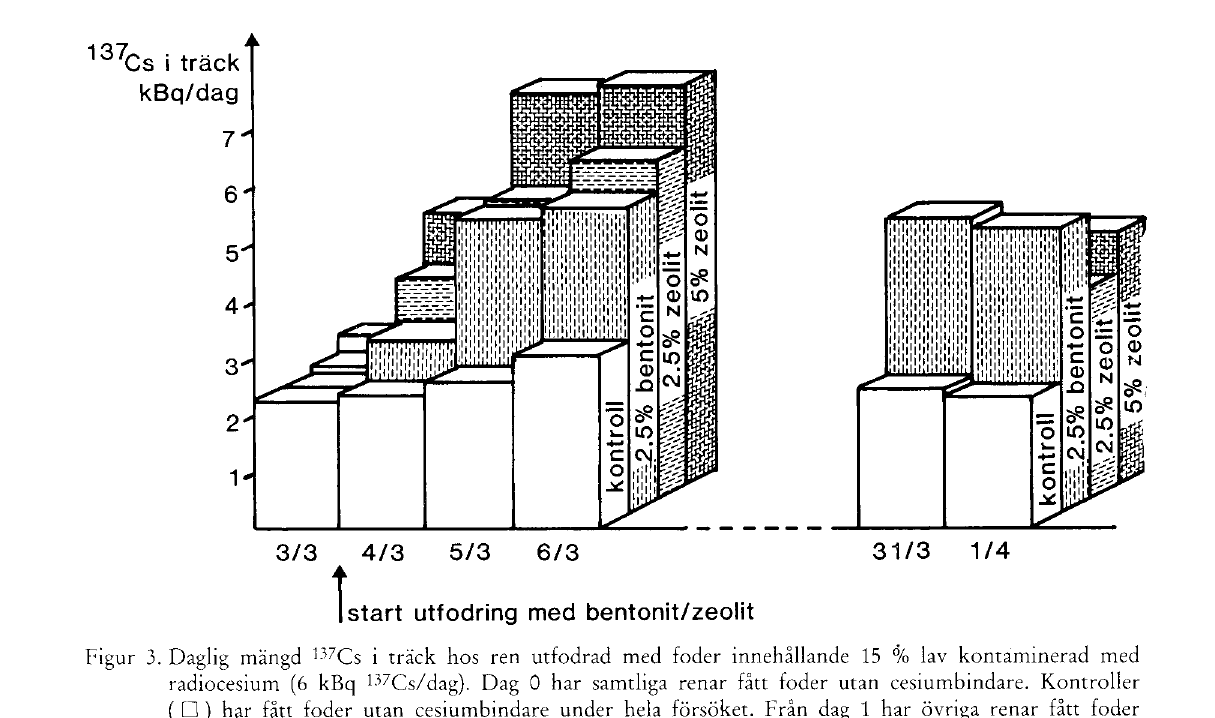
Figur 3. Daglig mångd 137 Cs i track hos ren utfodrad med foder innehållande 15 % lav kontaminerad med